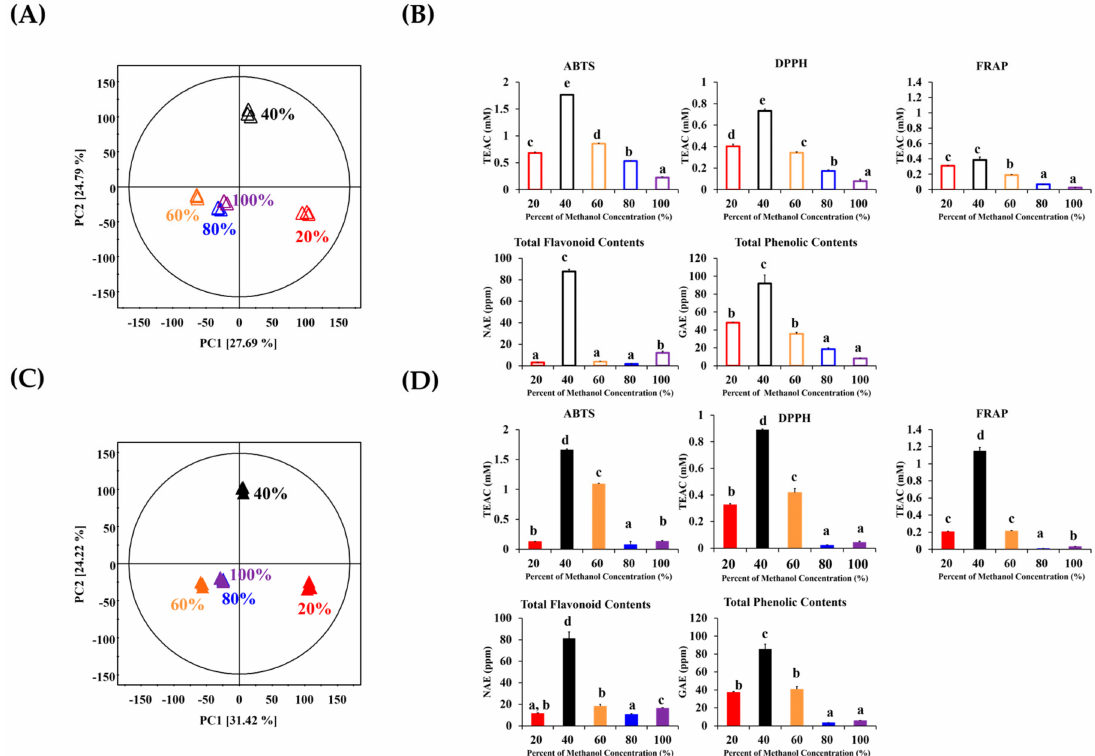
Figure 1. Principal component analysis (PCA) score plot ( A ) and ( C ) from UHPLC-LTQ-IT-MS/MS; antioxidant activity assays using ABTS, DPPH radical scavenging, FRAP, TFC, and TPC assays ( B ) and ( D ) derived from stepwise SPE extracts of A. aspera (unfilled column) and Z. serrata (filled column): red column 20% SPE extract, black column 40% SPE extract, orange column 60% SPE extract, blue column 80% SPE extract, and violet column 100% SPE